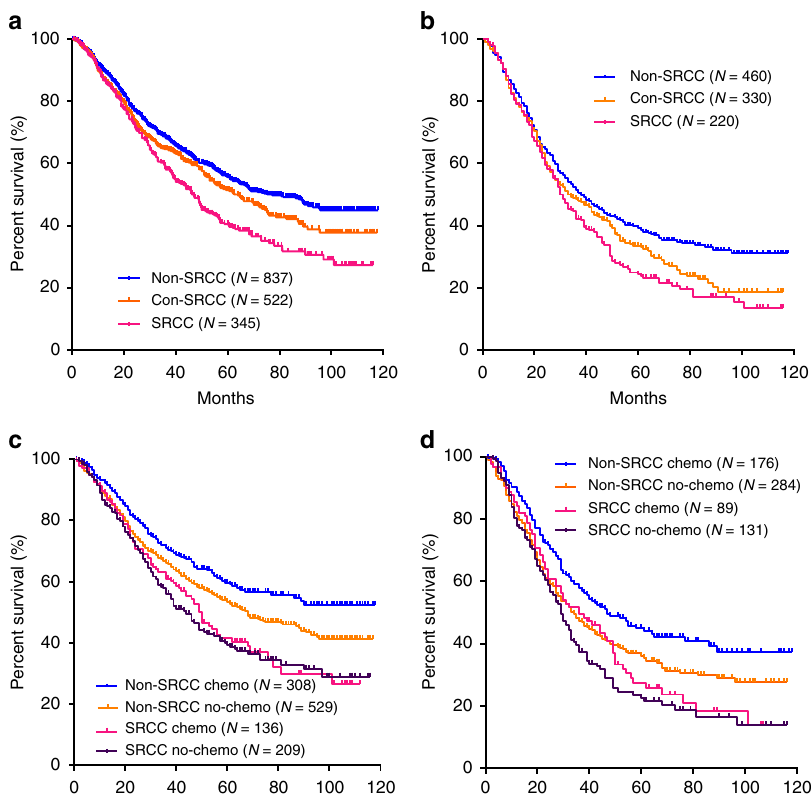
Fig. 1 Survival outcomes in gastric cancer patients with different signet-ring cell frequency (2006 – 2012). Survival curves of patients among the non-SRCC group ( N = 837), con-SRCC group ( N = 522), and SRCC group ( N = 345) were illustrated in all patients ( a ), and stages III/IV ( b ). Impact of